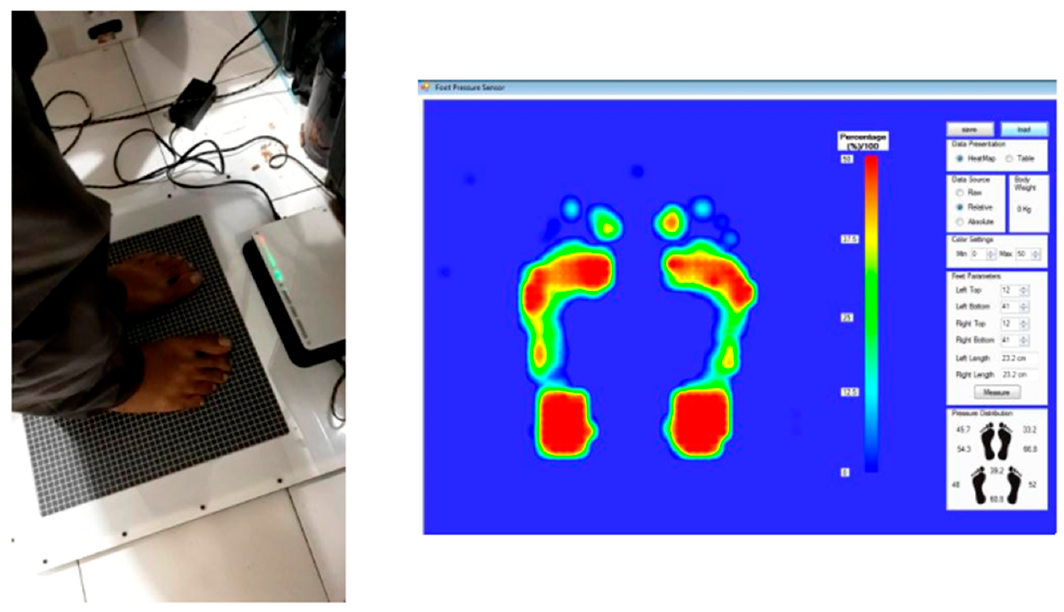
Figure 5. MAFP tool research results that also used in previous study by Wibowo et.al. [21]. Table 6. Sample comparison of measuring instrument results designed with MAFP measurement (sorted against type soles of foot).